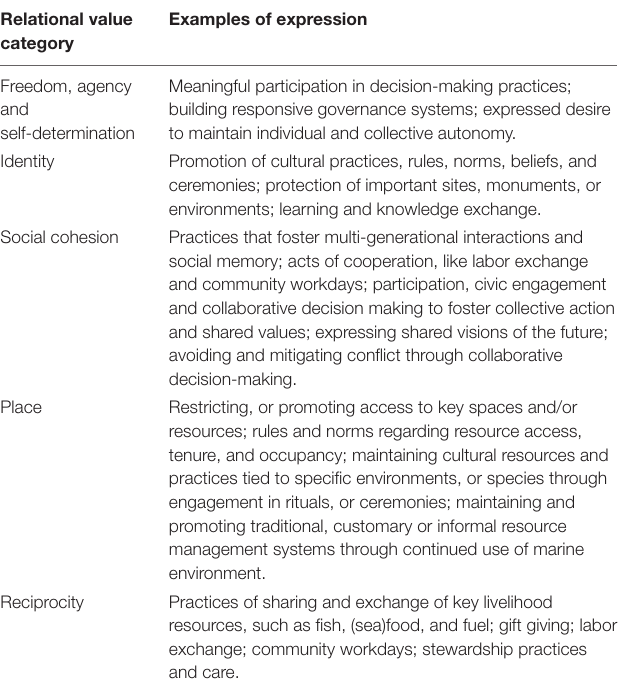
TABLE 1 | Key relational value categories that emerged as important to SSFs in MBREMP with associated practices and expressions. Relational value Examples of expression category